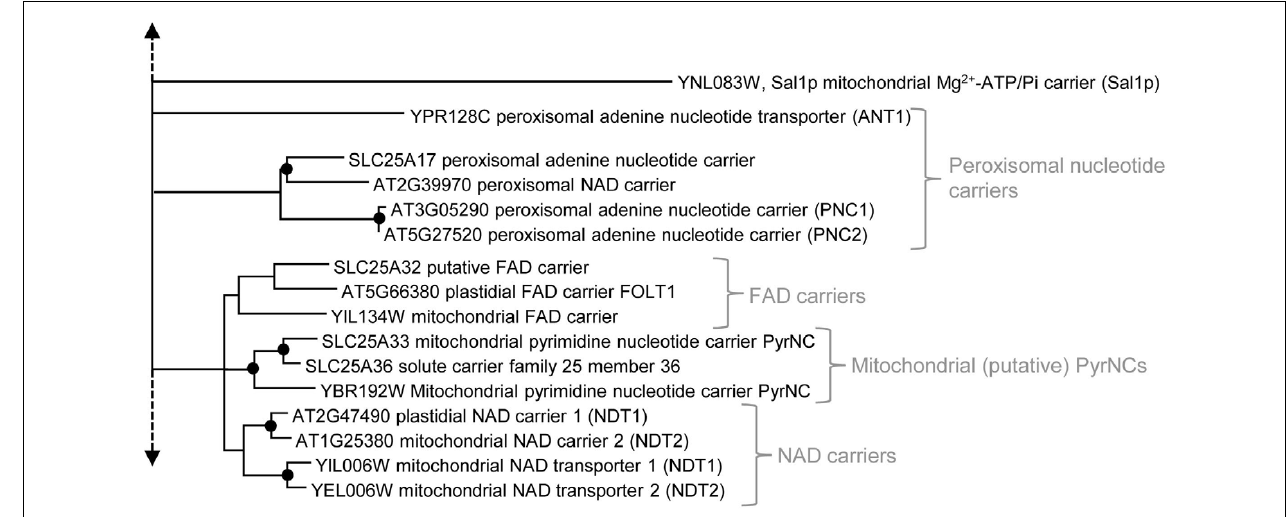
shaded subset and the mitochondrial Mg 2 + –ATP/Pi carrier (Sallp)]. Nodes that are supported by bootstrap values (maximum likelihood and maximum parsimony, 1000 replications) higher than 70 are indicated by black dots.